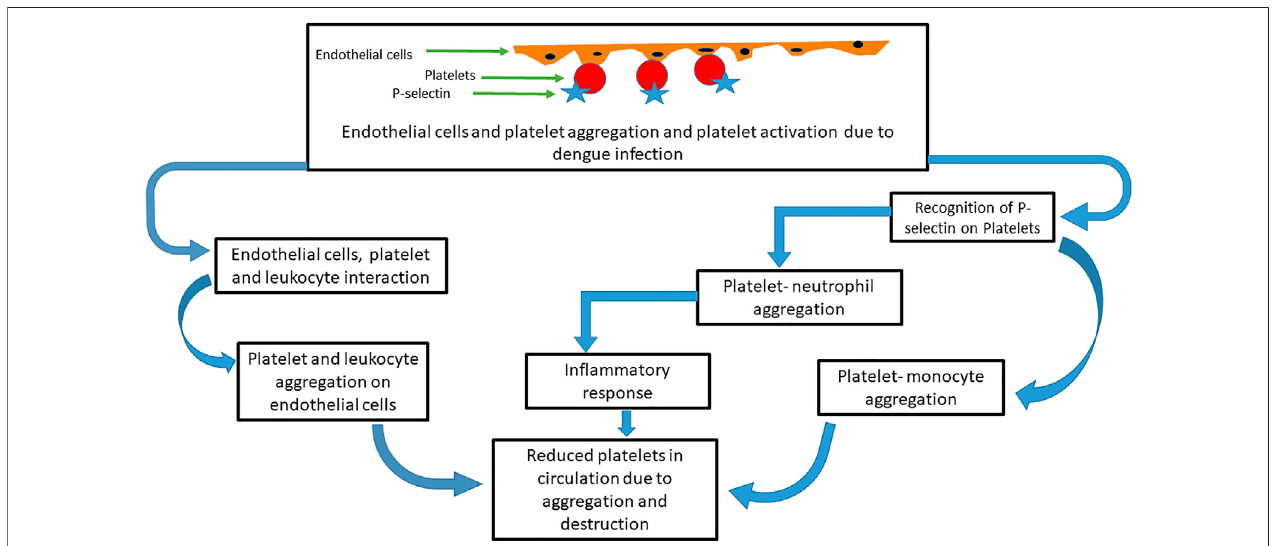
FIGURE 4 | Mechanism of platelets and other cells ’ aggregation in thrombocytopenia induced by dengue virus. After dengue infection, platelets are aggregated with endothelial cells that in turn activate the platelets. P-selection proteins on platelet cells are recognized by neutrophils and monocytes and form further aggregation. Leukocytes also interact with the platelet endothelial cell aggregates. These aggregations reduce the available platelet count and induce an in fl ammatory response that destroys the platelets.